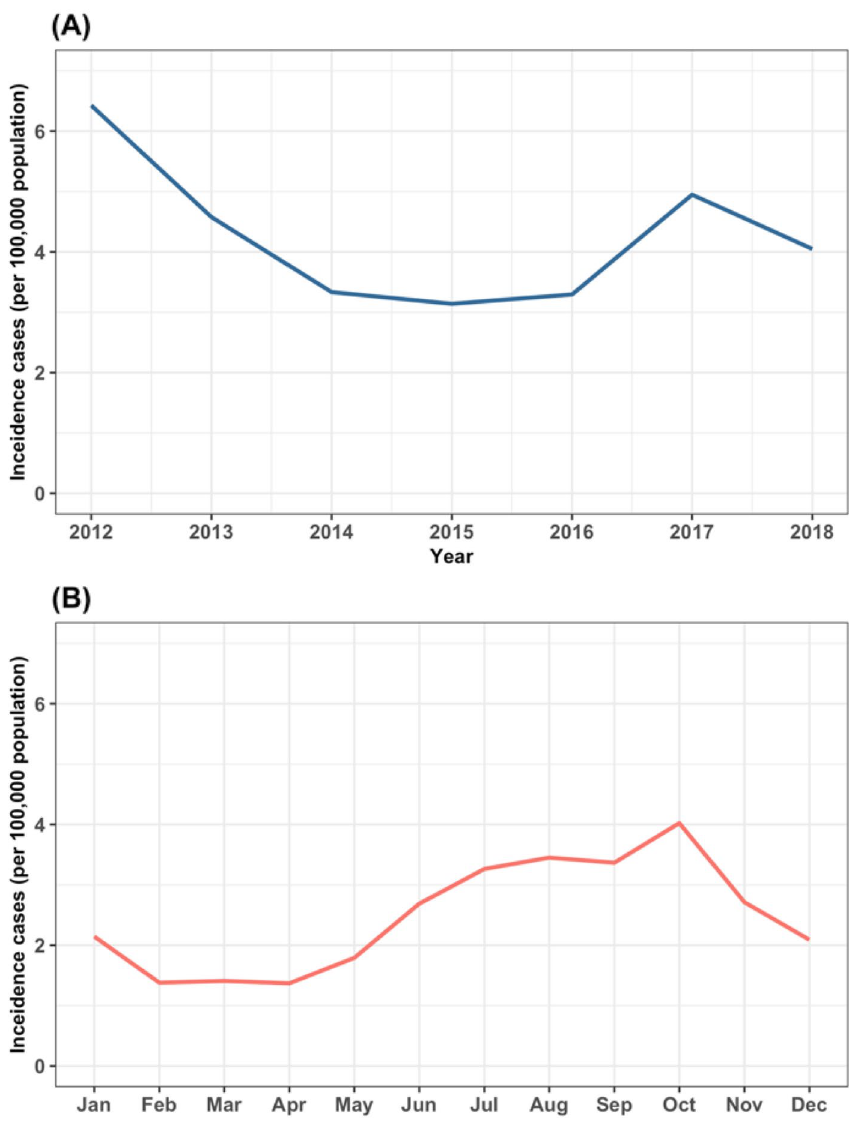
Figure 1. Annual ( A ) and monthly ( B ) leptospirosis incidence rates in Thailand (per 100,000